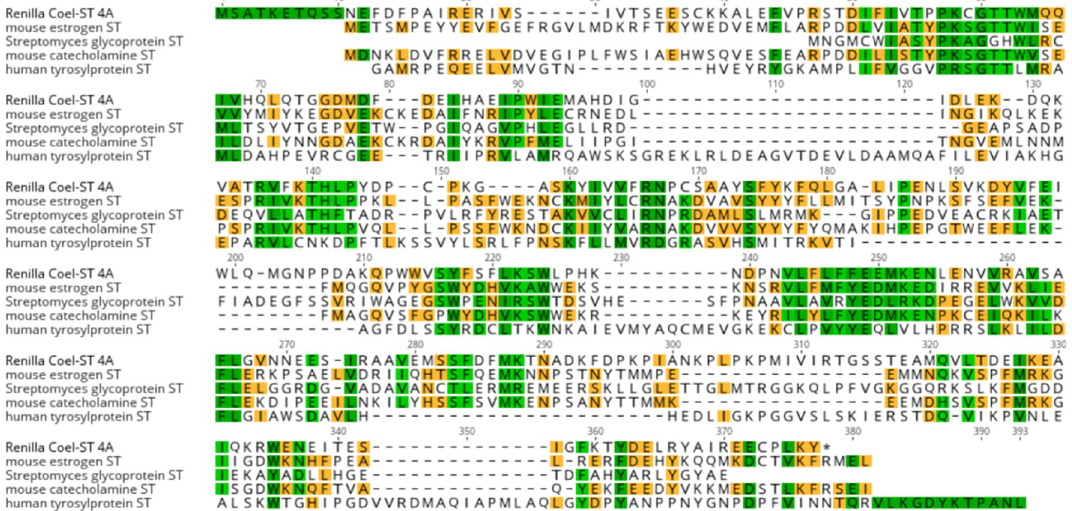
Fig 9. Alignment of five sulfotransferases. Amino acid sequence alignment of Renilla Coel_ST 4A with the four sulfotransferases assayed. The sequence similarity of all 5 sulfotransferases is indicated by color highlighting.